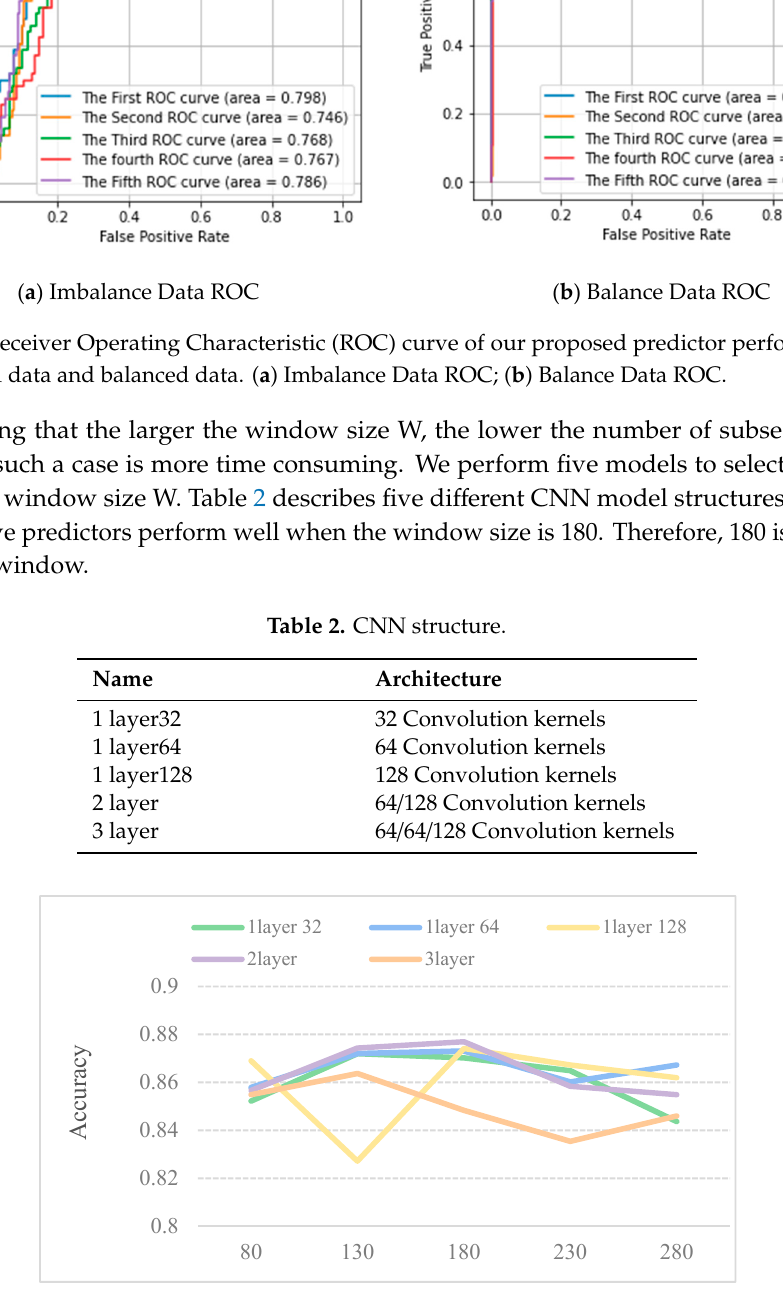
Figure 2. Accuracy of the di ff erent sliding window under di ff erent convolutional neural networks (CNN) structures on the dataset